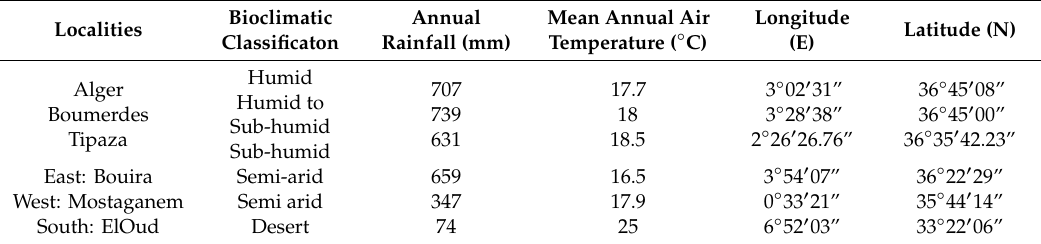
Table 4. Geo-ecological description with the location of sampling